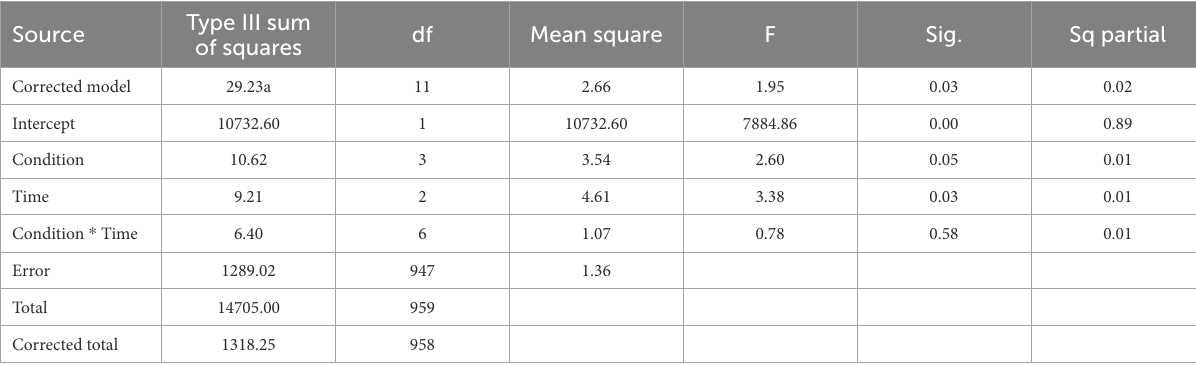
TABLE 4 “I Like Science” MLE univariate